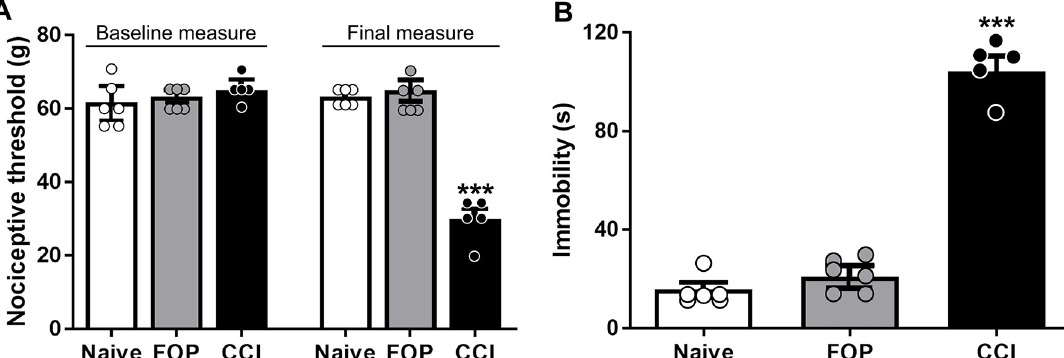
Fig 2. Behavioural results. A. Mechanical Nociceptive Threshold (g) in the paw pressure test before randomization (baseline measure) and after 14 days (final measure). A significant reduction in mechanical nociceptive thresholds represents neuropathic pain. B. Immobility time (s) in the Forced Swimming Test, evaluated 14 days after group allocation. Increased time spent immobile characterized depressive-like behaviour. Values are presented as mean ± SEM. ��� p < 0.001. Abbreviations: FOP: false-operated, CCI: chronic constriction